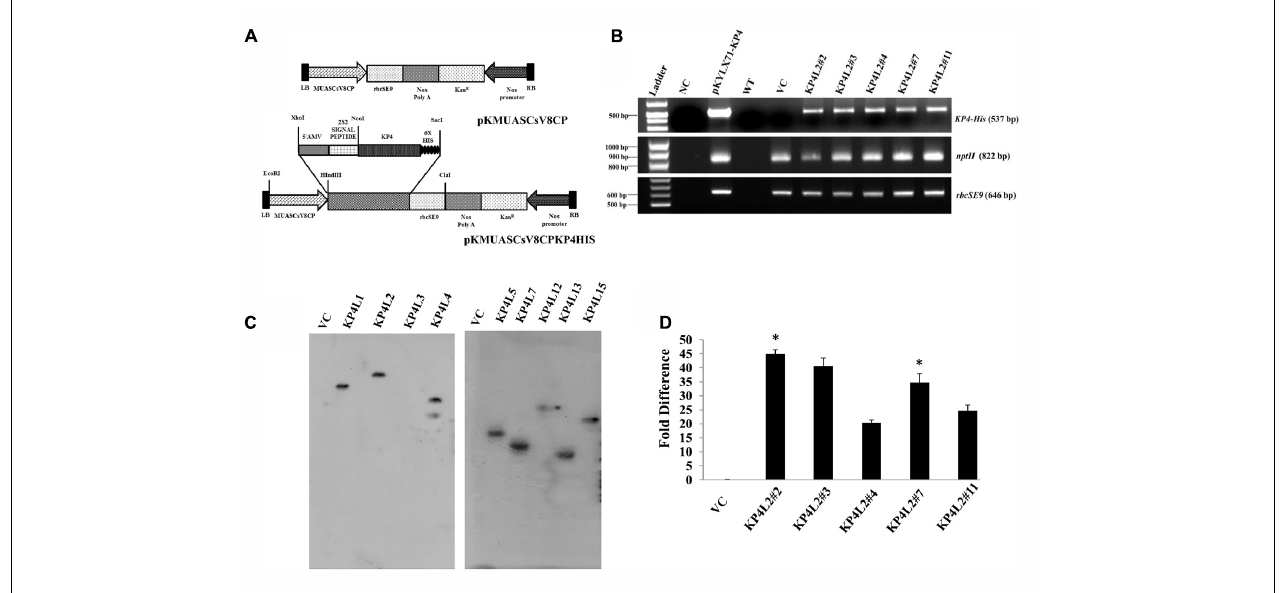
FIGURE 5 | Gene-integration analyses of transgenic plants expressing KP4. (A) Schematic representation of the plant transformation vectors for the expression of KP4. (B) PCR amplification of different genes viz. (i) KP4 (ii) rbcSE9, and (iii) nptII from transgenic plant lines KP4L2#2, KP4L2#3, KP4L2#4, KP4L2#7, and KP4L2#11. The KP4 amplicon was electrophoresed along with a 1 kb DNA ladder (BioLit ProxiO 1 kb DNA Ladder plus BLL007) while the amplicons of rbcSE9 and nptII were electrophoresed along with a 100 bp Ladder (Thermo Scientific GeneRuler, 100 bp DNA Ladder #SM0241). (C) Southern blot analyses to check the copy number of the KP4 transgene in the above transgenic plant lines. (D) Real-time PCR analyses to check the abundance of KP4 m-RNA in different transgenic lines. Asterisks indicate level of significance where “ ∗∗ ” is more significant than “ ∗ ”.